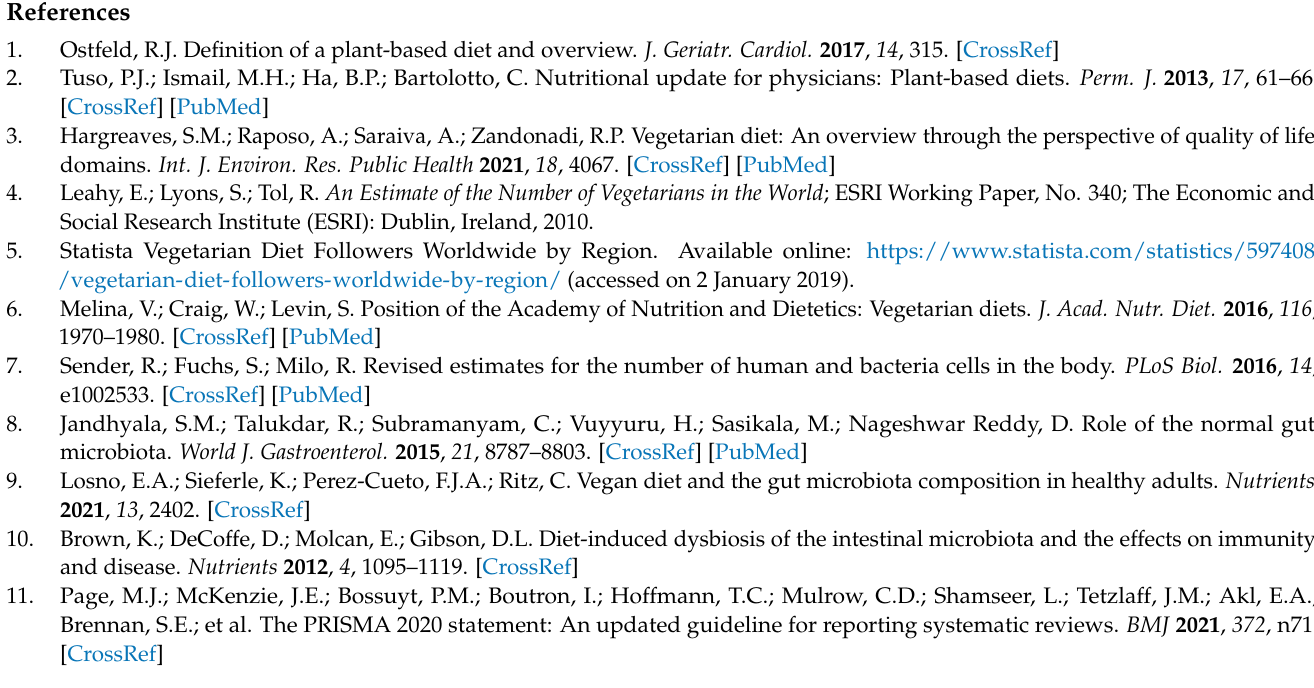
strategy; Table S3: Extracted information from eligible studies; Table S4: Quality assessment for intervention studies (NIH tool); Table S5: Quality assessment for pre-post studies (NIH tool); Table S6: Quality assessment for non-randomized study (ROBINS-I tool); Table S7: The statistically increased bacterial taxa in vegans, vegetarians and omnivores; Table S8: The statistically decreased bacterial taxa in vegans, vegetarians and